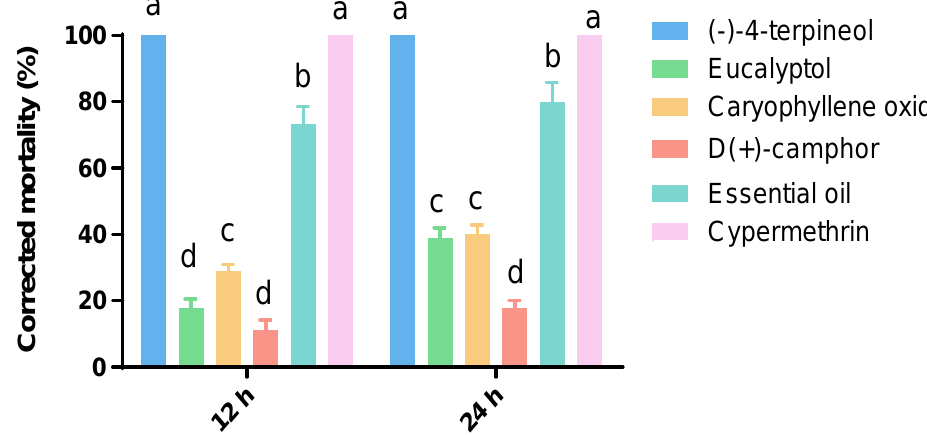
Figure 1. Total iron current chromatogram of the essential oil from A. lavandulaefolia.